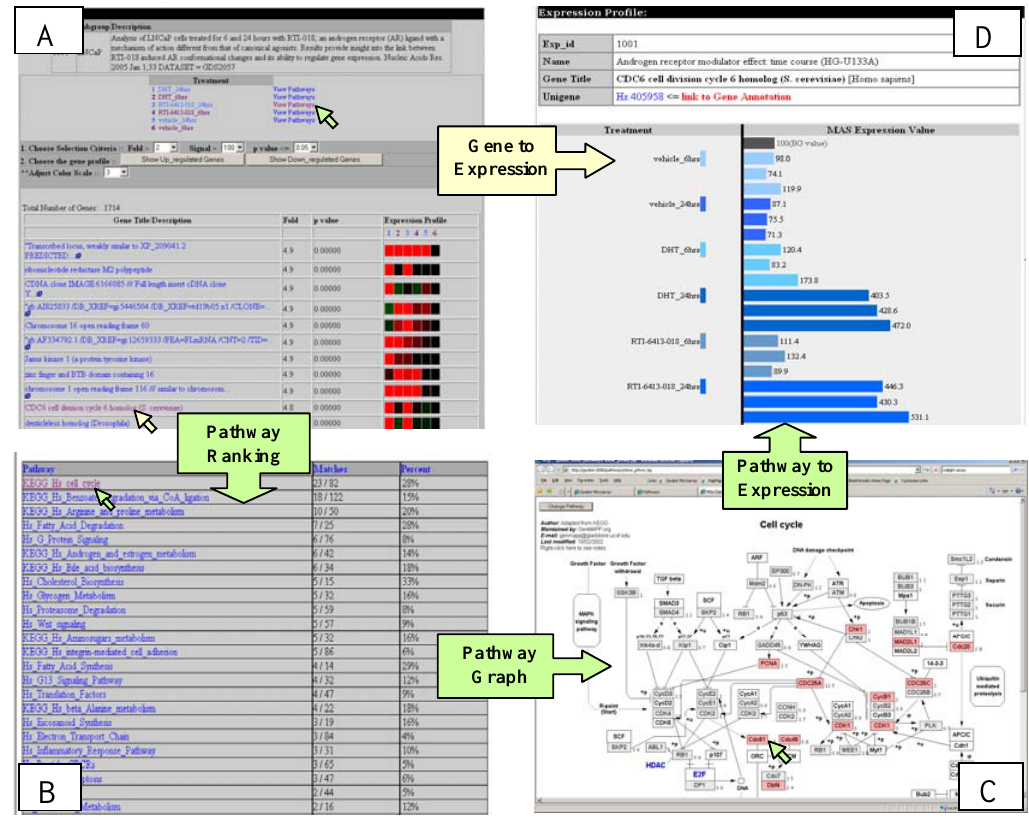
Figure 3: Flowchart of experiment based query in Goober web